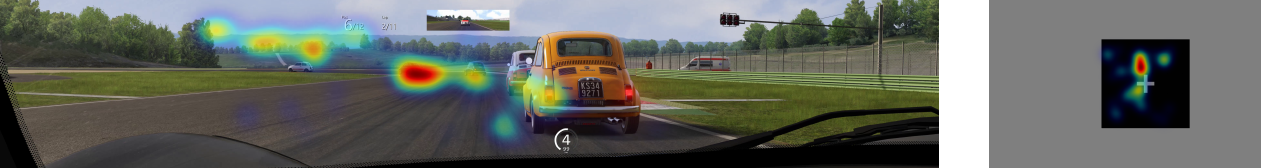
Figure A1. Fixation heatmaps for k -drive ( left ) and n -back ( right ) scenarios over a two-minute time interval. Darker (red) clusters show a high frequentness of fixations at this location.